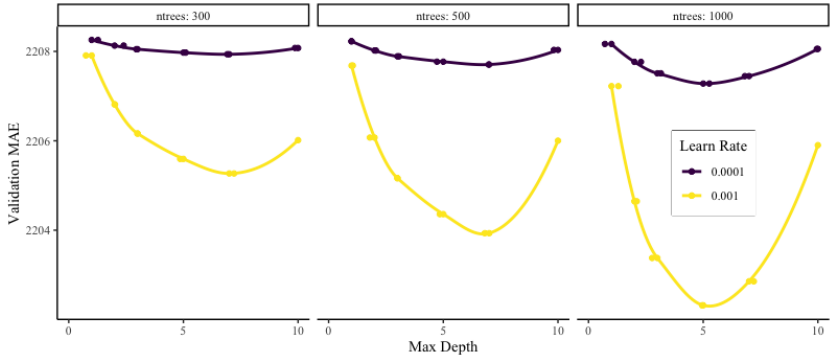
Figure 17. Visualization of the results from tuning random forests to predict severity on the COLL data. MAE (as computed on the validation set) is shown on the y -axis as it varies according to the max depth of each tree in the forest. Each pane shows a different minimum split improvement value, with the different colors representing different values of the mtry tuning parameter.